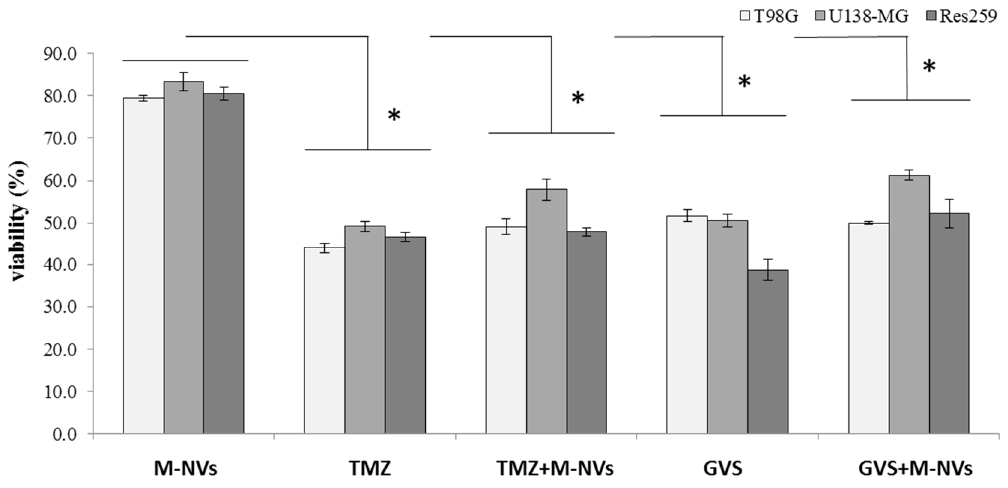
Figure 9. Cytofluorimetric viability assays in three different human astrocytoma cell lines (i.e., T98G, U138-MG and Res259) at 24 h after direct administration of mock plasma membranes generated vesicles (MVs), Temozolomide (TMZ) or Givinostat (GVS) and M-NVs loaded with TMZ or GVS separately (each 50 µ M). Experiments were in triplicates analyzing 5000 cells for each treatment and asterisks indicate p < 0.05, Anova One-way compared to mock samples.